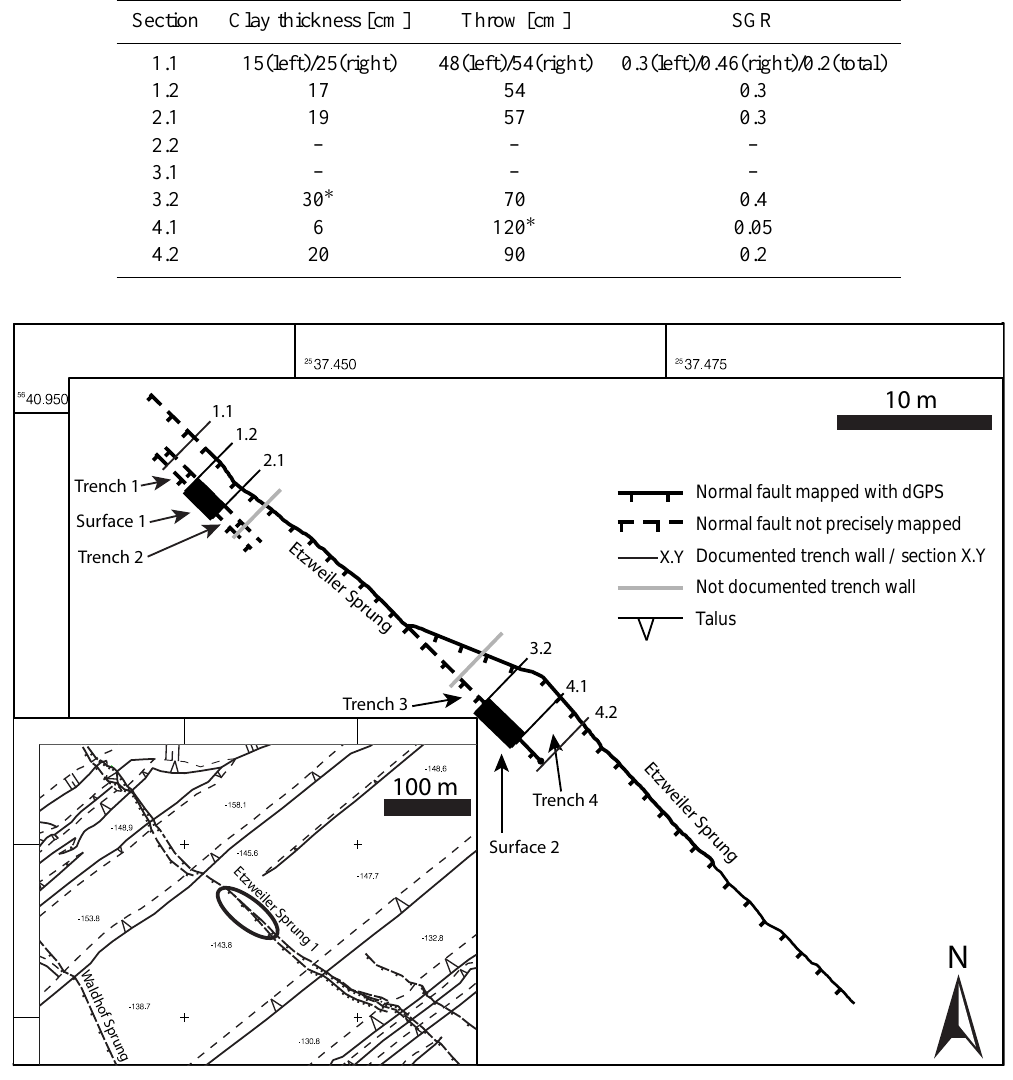
Figure 4. Fault map of the outcrop different scales. Trenches, vertical profiles and excavated surfaces are indicated and numbered. Maps provided by RWE Power AG. Continuous fault line in large map derived from differential GPS measurements. Dashed lines show location of imprecisely defined fault